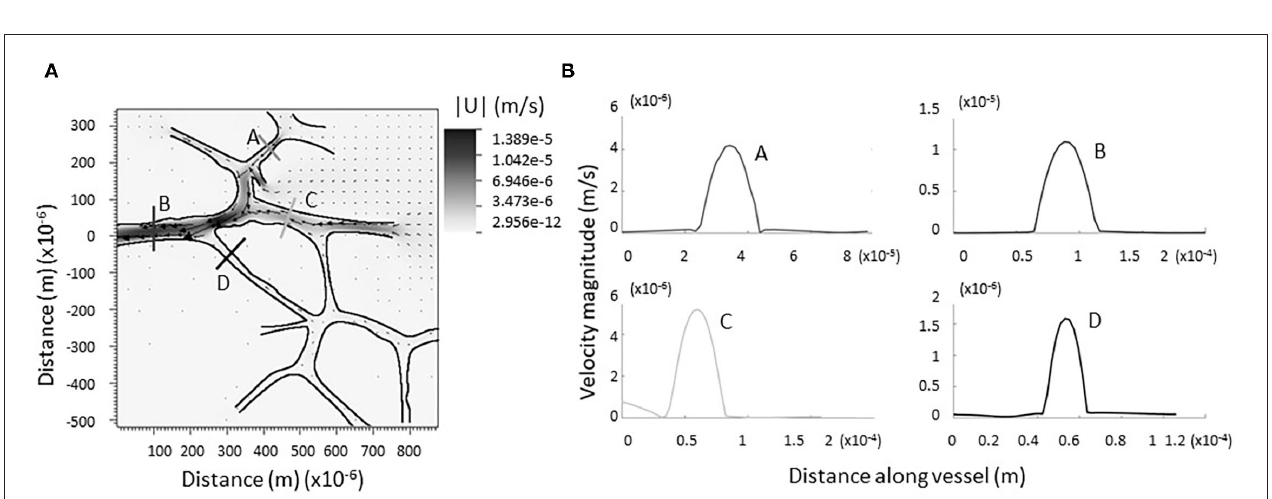
FIGURE 4 | Computational model of lymph flowing through larger network of dermal capillaries. (A) As in the single junction analysis, no regions of backflow are evident. The trend is preserved in each individual junction. Vectors represent the direction and magnitude of flow. The heat-scale map gives the magnitude of the velocity. (B) Verification flow remains parabolic or nearly parabolic at representative cross sections (coded by lettering).